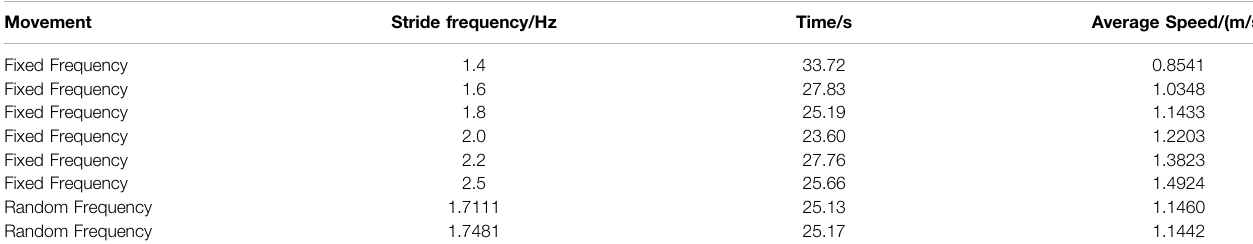
TABLE 6 | Experimental data of tester 3 walking at different step frequencies. Movement